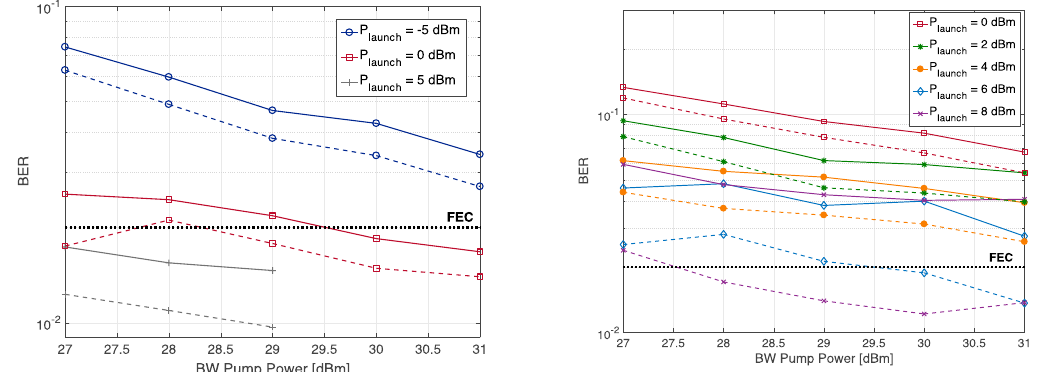
Figure 3. Bit error rate (BER) vs. back propagation (BP) powers for different launch powers in 160 - km (left) and 20- km (right) experiments with (dashed) and without (solid) DBP.